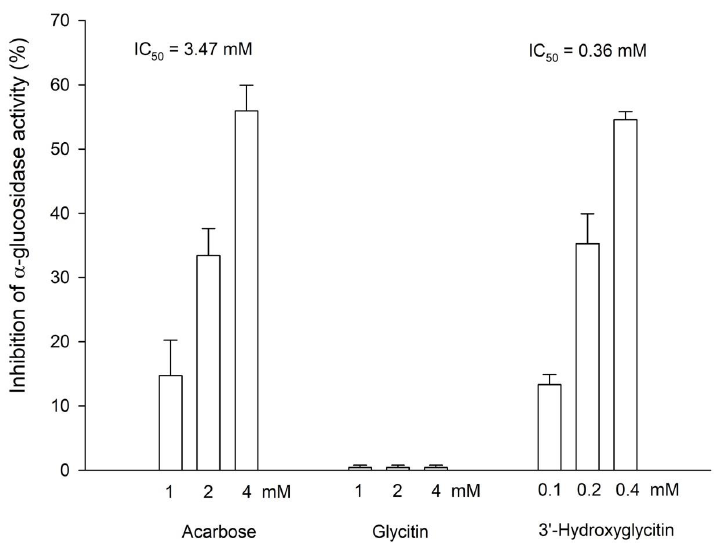
Figure 5. Inhibition of a -glucosidase activity by acarbose, glycitin, and 3′-hydroxyglycitin. The initial rate (R i ) was recorded from the slope of the linear plot of absorbance versus time in each reaction. Acarbose was used as a positive control, and DMSO was used as a negative control. The inhibition of enzyme activity was calculated as follows: Inhibitory effect (%) = (R i of negative control − R i of the tested compound)/R i of negative control × 100. The mean ( n = 3) is shown, and the standard deviation is represented by the error bar. The IC 50 values represent the concentrations required for 50% inhibition activity.